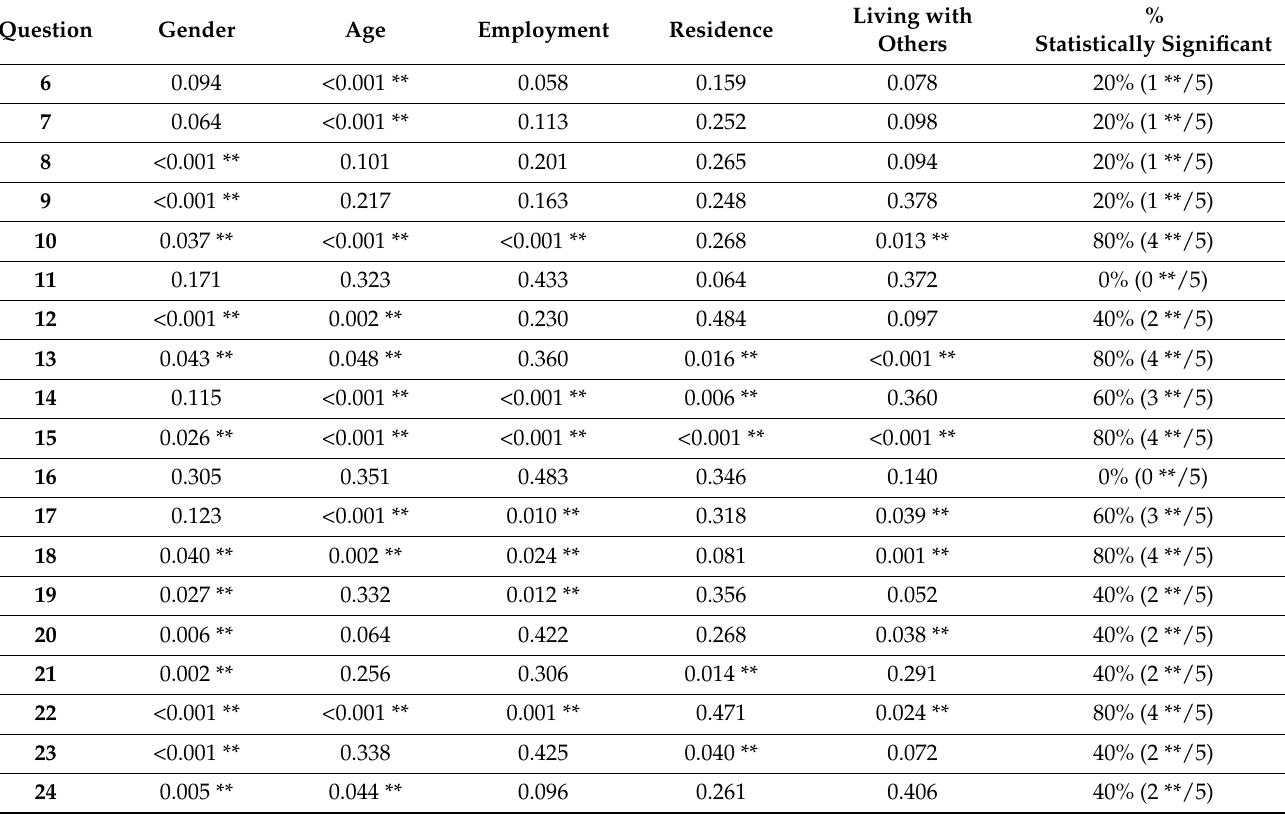
Table 1. Correlation of the questionnaire questions with the independent variables, based on the p